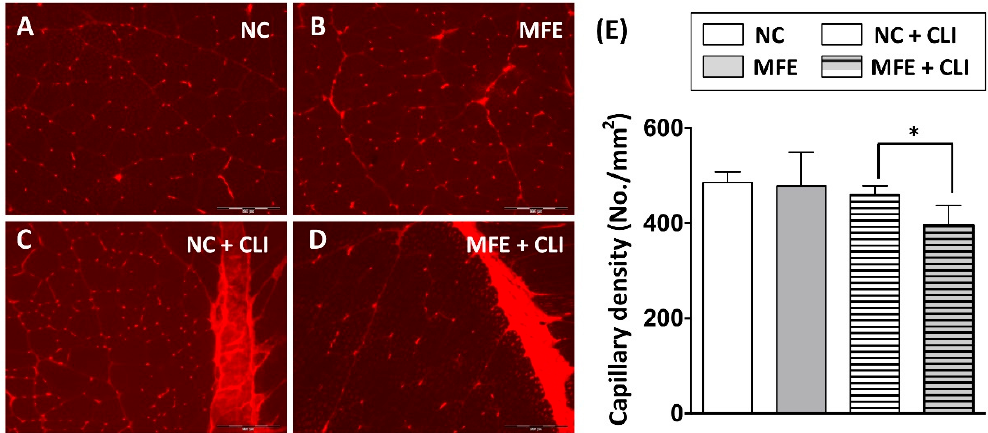
Figure 4. Capillary density in ischemic quadriceps was reduced by maternal fructose exposure. ( A – D ) Immunofluorescent staining to detect the distribution of CD31+ capillaries in quadriceps. ( E ) Calculation of capillary density in quadriceps. In normal condition, the capillary density showed no difference between the NC and MFE groups. By 14 days after induction of CLI, the capillary density in MFE group was significantly lower than that in NC group. NC, normal control; MFE, maternal fructose exposure; CLI, critical limb ischemia. Scale bar in the lower-right corner indicates 200 μ m. Error bars represent the standard deviation (SD). * Indicates statistical significance between NC and MFE group. n = 8 for each group.